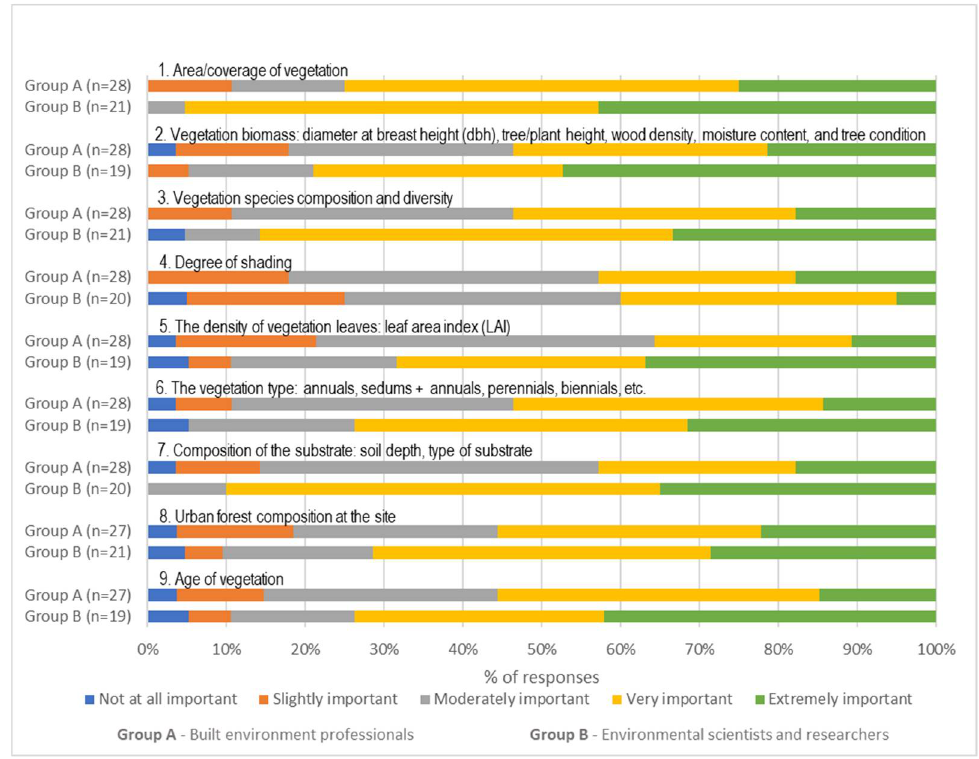
Figure 7. Parameters for assessing building-related carbon sequestration strategies.